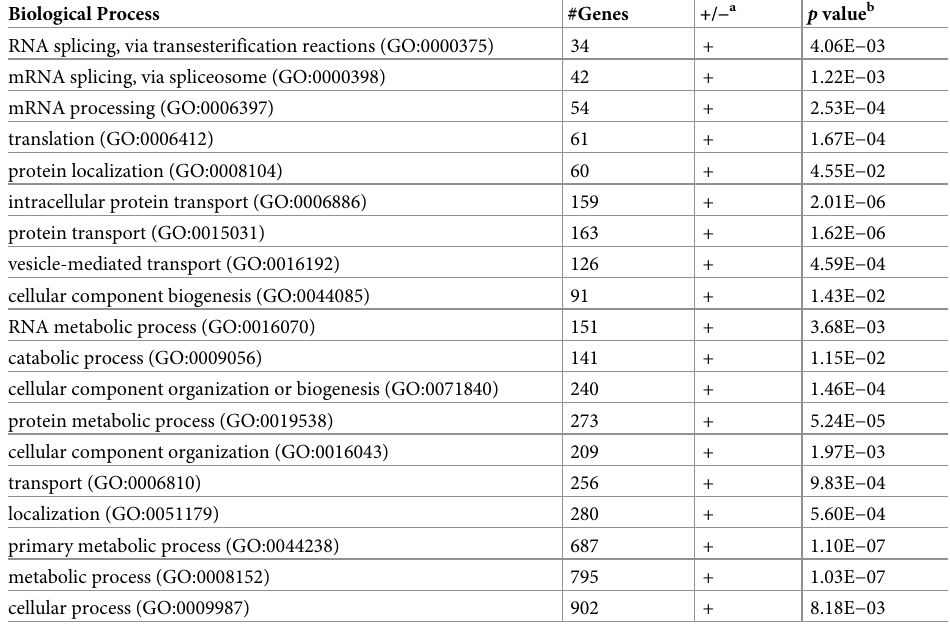
Table 9. GO overrepresentation analysis of differentially spliced genes. Biological Process p value b RNA splicing, via transesterification reactions (GO:0000375)